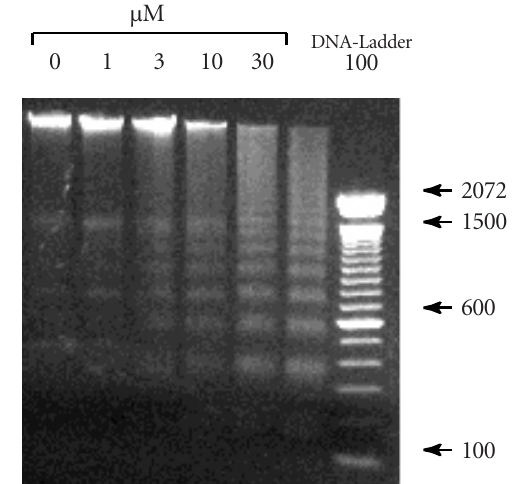
Figure 6: DNA fragmentation in rat peripheral blood lympho- cytes exposed to CI-994 for 24hours. Mitogen (concanavalin A, 0.63 µ g/ml) was added to all lymphocyte cultures at time